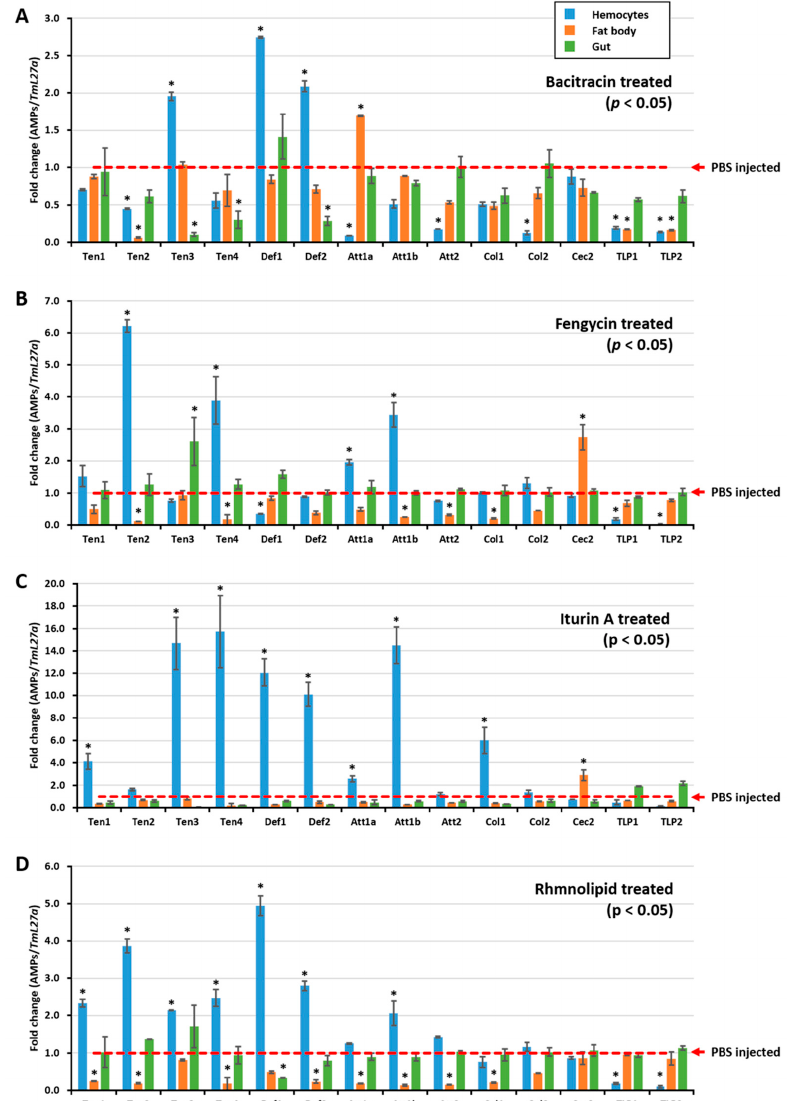
Figure 2. Biosurfactant-induced expression of antimicrobial peptides in T. molitor . The AMP expression levels were assessed 24 h after injecting either bacitracin ( A ), fengycin ( B ), itiurin A ( C ), or rhamnolipid ( D ) into T. molitor larvae. Three tissues—hemocytes, fat body, and gut—were then dissected. The expression of AMPs in each tissue was quantified by qRT-PCR, using specific primers. The expression results are presented as mean of three replicates. * significant difference ( p < 0.05) in AMP expression, compared to the PBS-injected group. The AMP expression results revealed that all tested biosurfactants induced di ff erent types of AMPs in